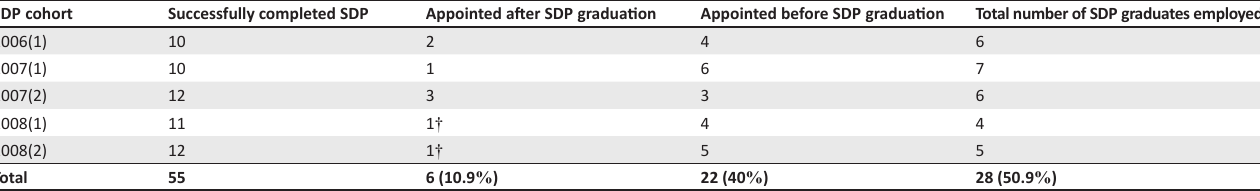
TABLE 6: Supervisory development programme participant appointments prior to or after supervisory development programme. SDP cohort